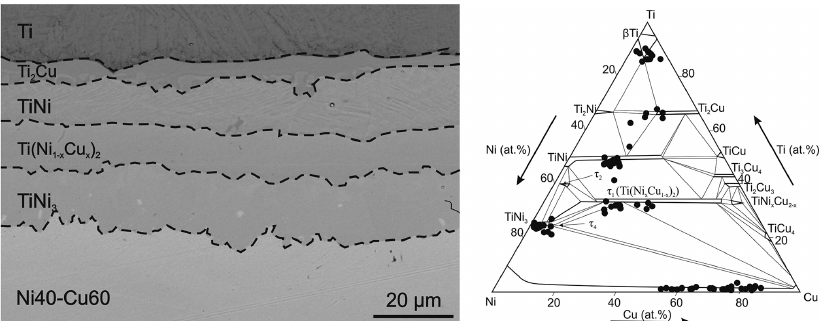
Figure 3: Left – the microphotography showing grown intermetallic phases, right – the diffusion path in diffusion couple experiment Ti-Ni40Cu60 at 1,123 K after 160 h.